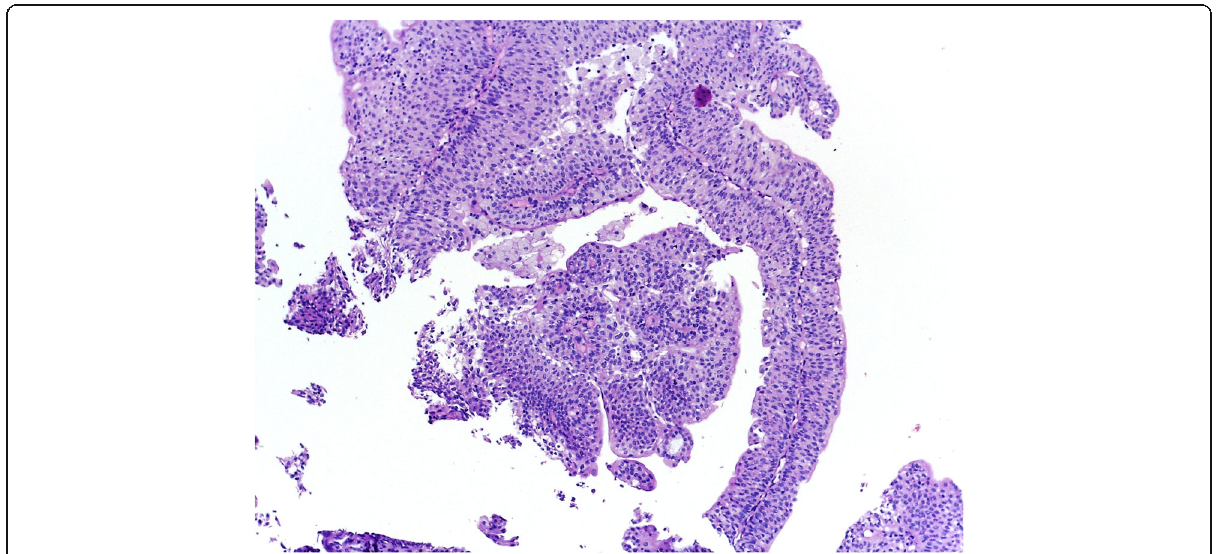
Fig. 2 Papillary urothelial lesion (H&E; 10x). It is defined by the presence of a fibrovascular core, which is depicted transversally in the center of the figure, and longitudinally in the right side. It is a low grade well differentiated lesion, with relatively uniform cytology and maintenance of polarity towards the basement